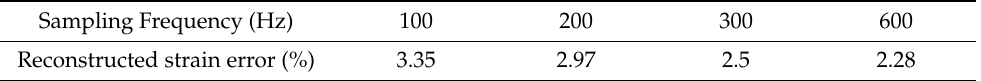
Figure 22. The effect of sampling frequency on the identified loads at speed 0.47 m/s. ( a ) front axle load, ( b ) rear axle load, ( c ) resultant axle load. Table 12. The percentage error at different levels of sampling frequency at speed 0.47 m/s